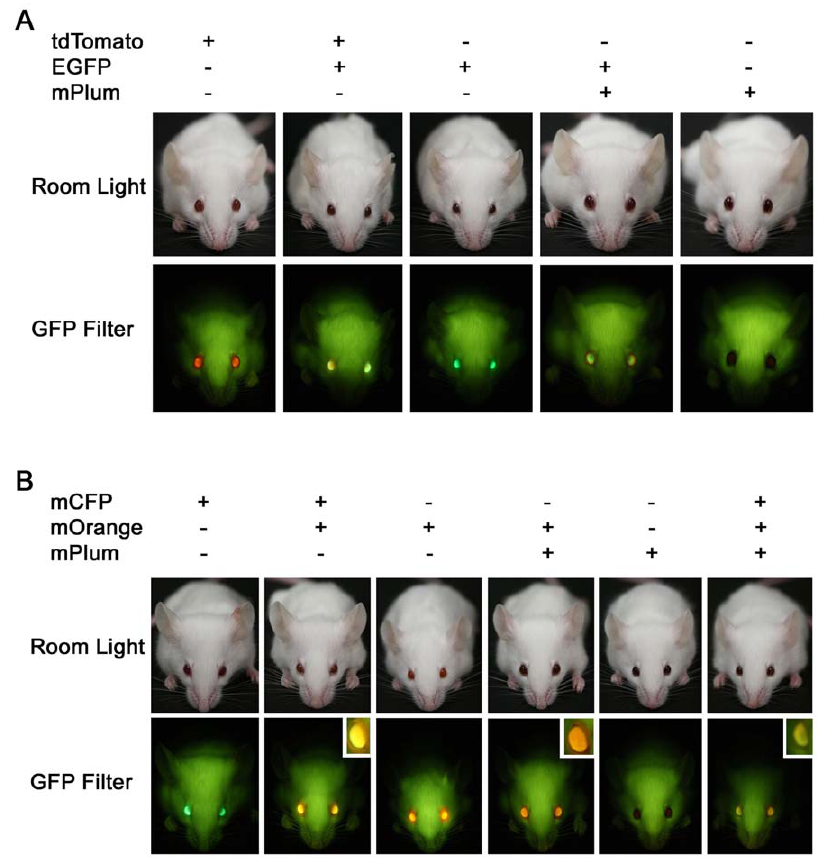
Figure 5. Fluorescent eye markers allow visual identification of double and triple transgenic mice. (A) Double transgenic mice carrying the EGFP marker and either tdTomato or mPlum can be easily distinguished from single transgenic littermates under the GFP flashlight. (B) Single, double and triple transgenic mice can be identified using mCFP, mOrange and mPlum eye markers. All six possible combinations are distinguishable under the GFP flashlight. Insets show close up view of fluorescence in the eyes of double and triple transgenic